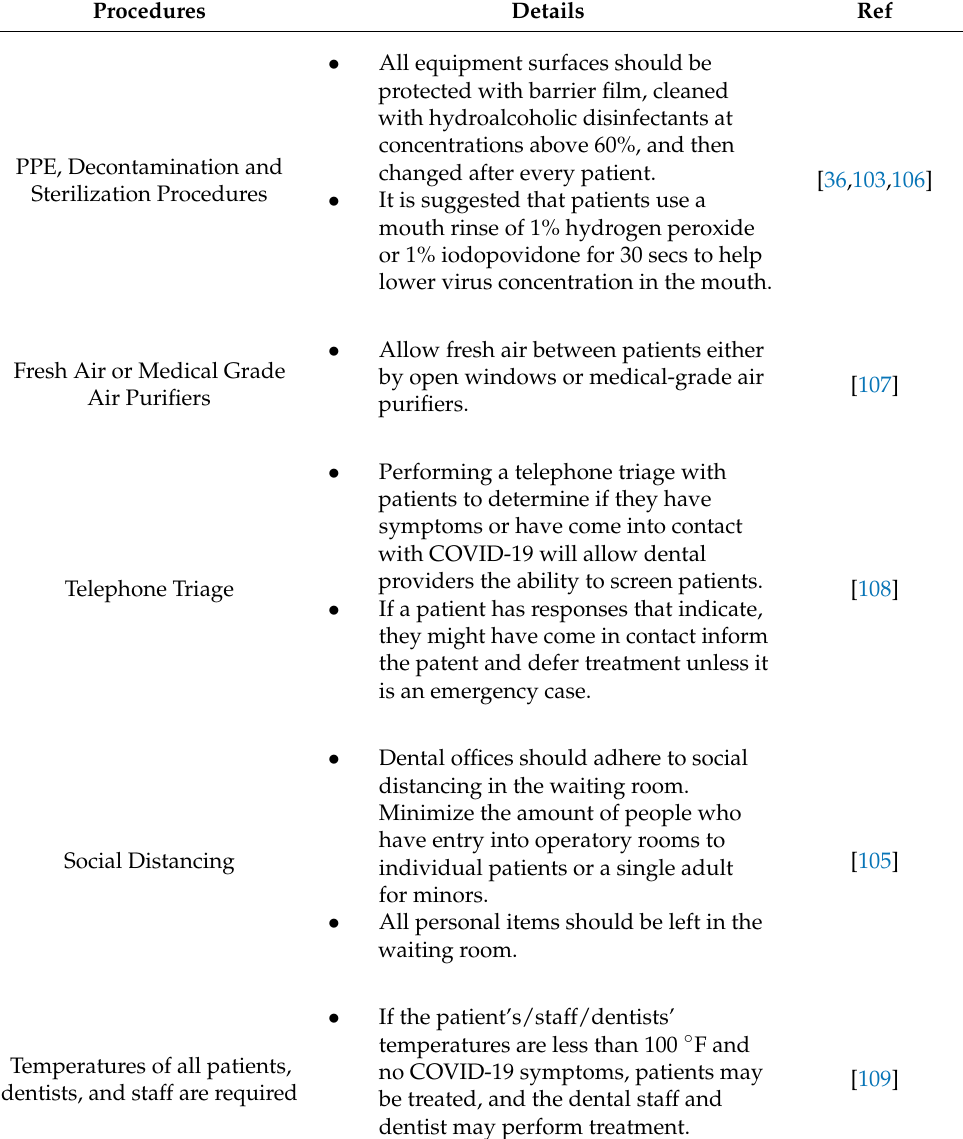
Table 1. Effective COVID-19 Practices for a Dental